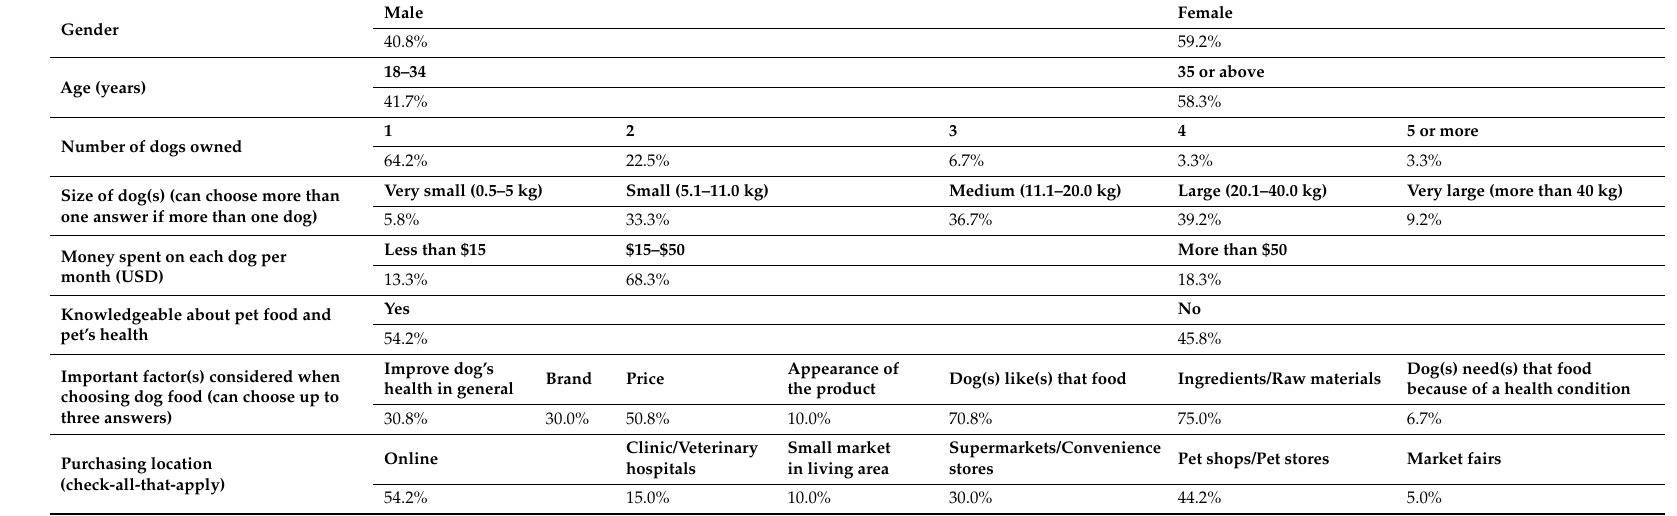
Table 2. Summary of the demographics of the participants in the consumer study